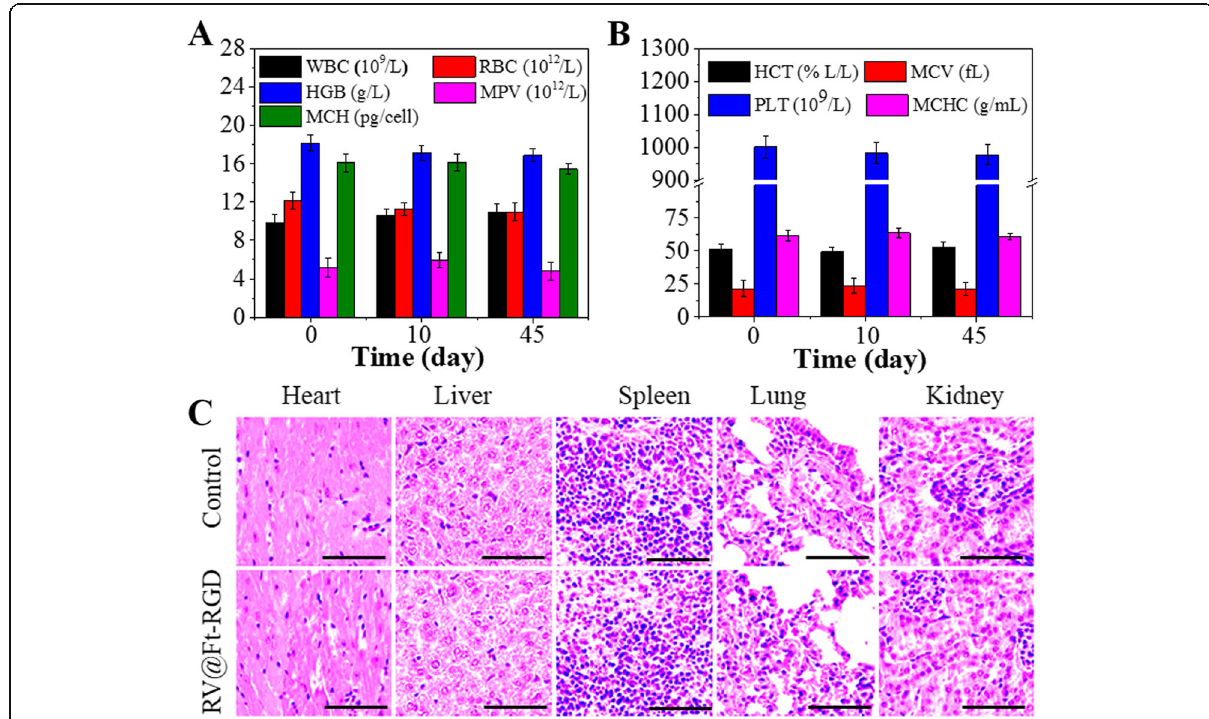
Fig. 8 a Blood analysis of health mice treated with RV@Ft-RGD for 45 days. b Images of H&E-stained major organs of healthy mice treated with RV@Ft-RGD for 45 days. c The HE staining images major organs in control and RV@Ft-RGD treated groups. Scale bars are 50 μ